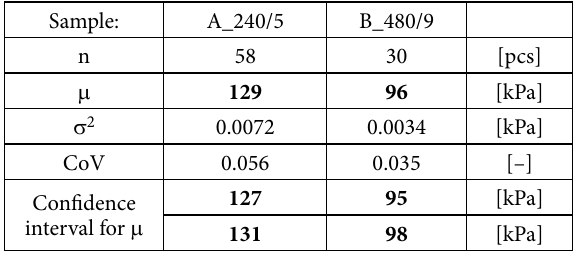
Table 4. Interval estimation of mean and variance of stipulated